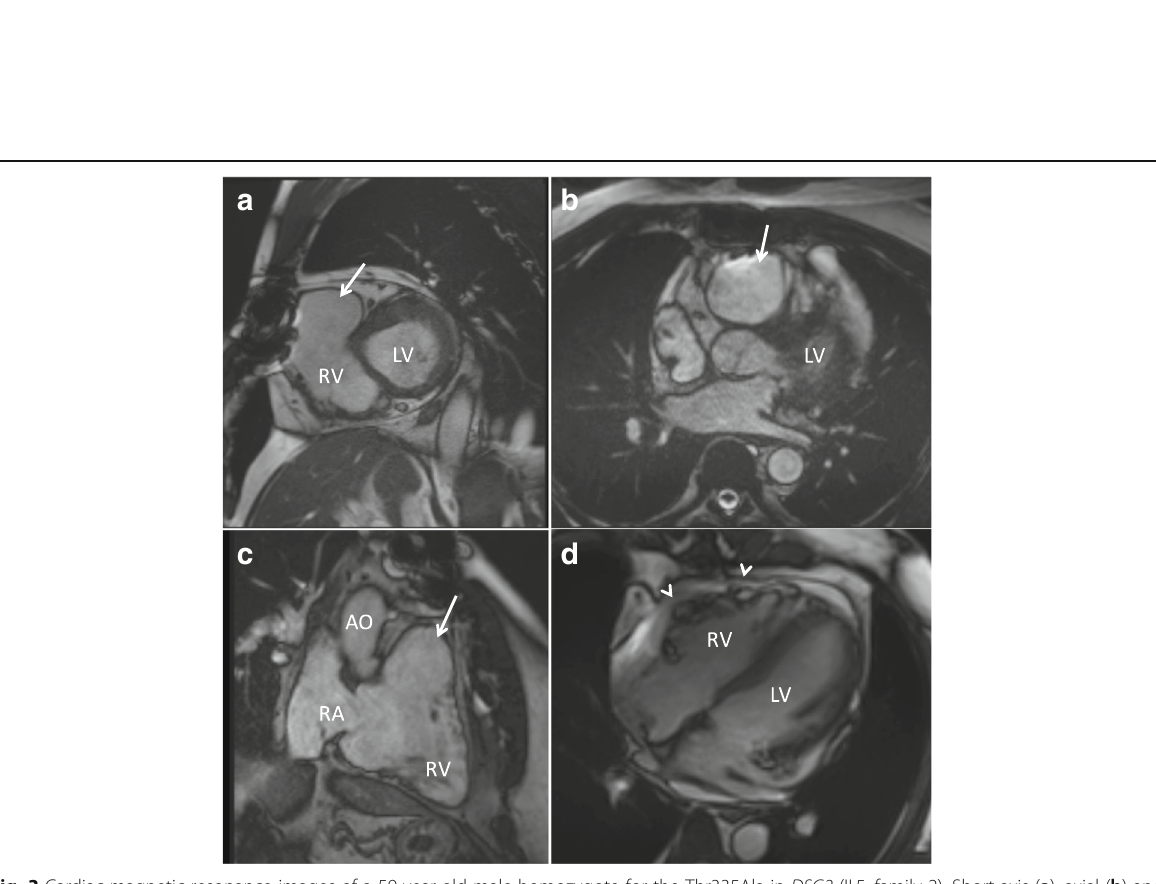
Fig. 3 Cardiac magnetic resonance images of a 59-year-old male homozygote for the Thr335Ala in DSG2 (II.5, family 2). Short-axis ( a ), axial ( b ) and right ventricular outflow tract (RVOT) ( c ) views of the heart show aneurysmal dilatation of the RVOT (arrows). Maximum dimension of the aneurysm was 67 mm and right ventricular end-diastolic volume index (RVEDVI) was 109 ml/m 2 . During follow-up, further dilatation of the aneurysm and the RV was observed. Four-chamber view shows rare microaneurysms in the right ventricular free wall (arrowheads) ( d ). LV = left ventricle; RV = right ventricle; RVOT = right ventricular outflow tract; RA = right atrium; AO =